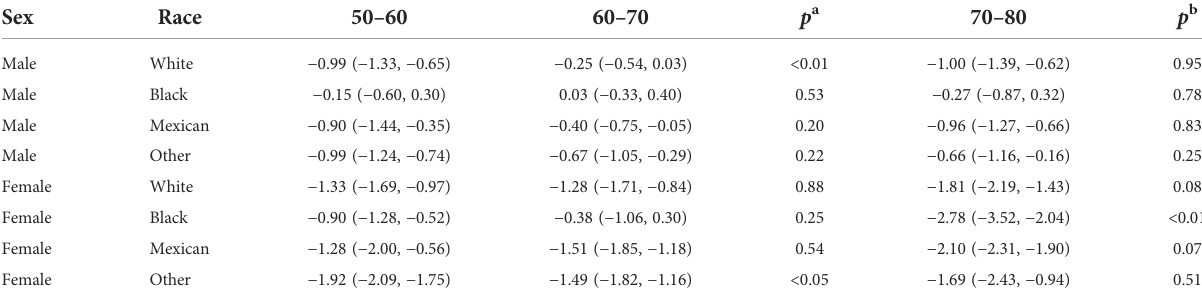
TABLE 2 Mean T-scores, by race, sex, and age